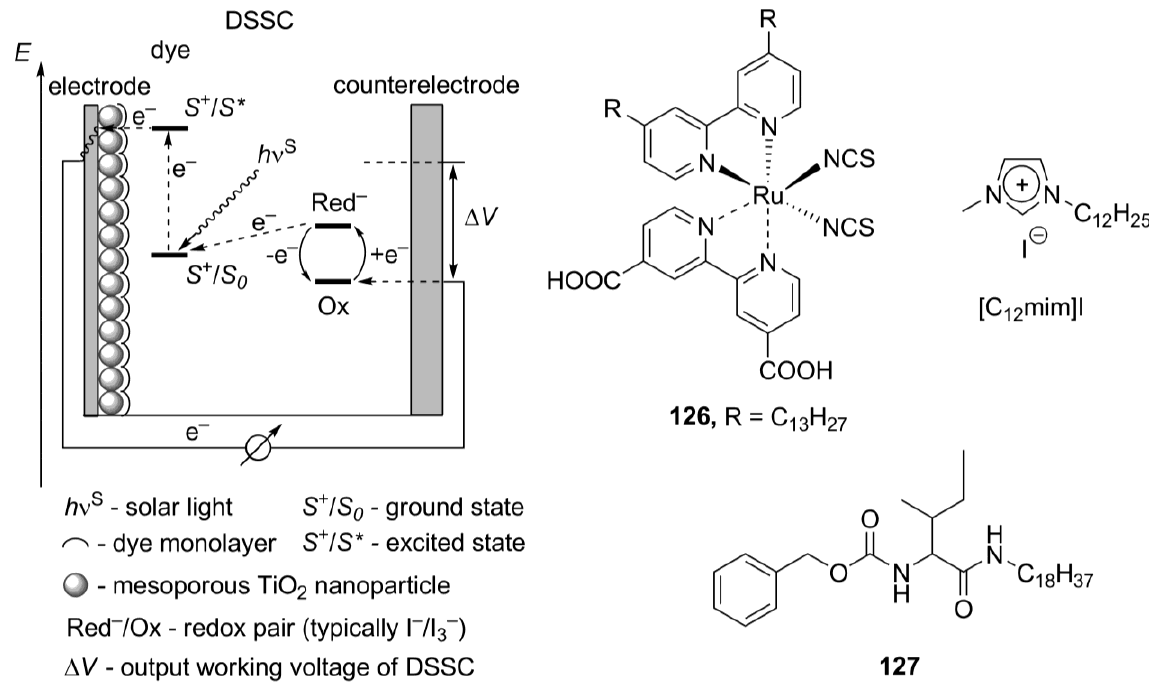
Scheme 27. Schematic representation of a